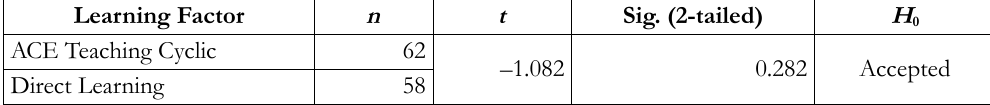
Table 4. The Difference Test Result of N-Gain Data of Overall